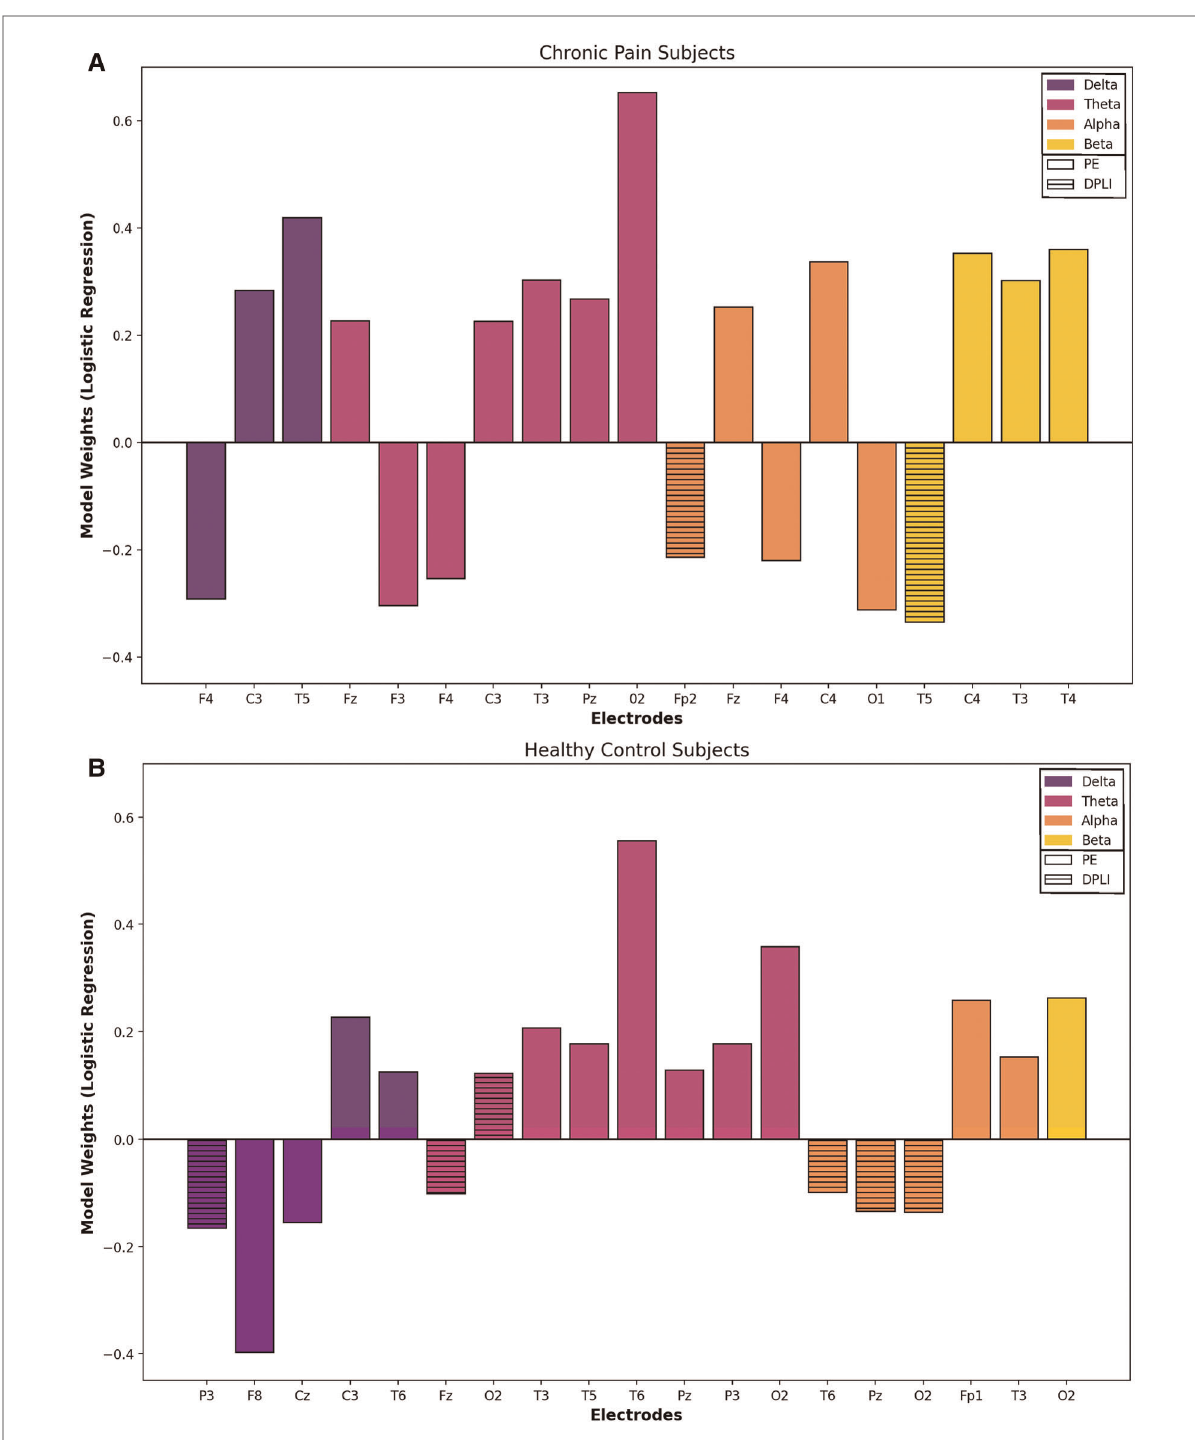
FIGURE 2 Baseline vs. CPT: feature importance. Most important features (top 10%) for classifying between pain and no pain conditions based on logistic regression model weights for chronic pain ( A ) and healthy ( B ) participants. Note : Model coef fi cients cannot be generated when using a radial basis function kernel for SVM models; thus, overall model feature importance was only explored using the logistic regression models. Solid boxes represent permutation entropy features, while stripped boxes indicate directed phase lag index features. No graph theory or peak frequency features were in the top 10% based on model coef fi cients. Positive model weights are predictive of tonic cold pain conditions, while negative model weights are predictive of no-pain